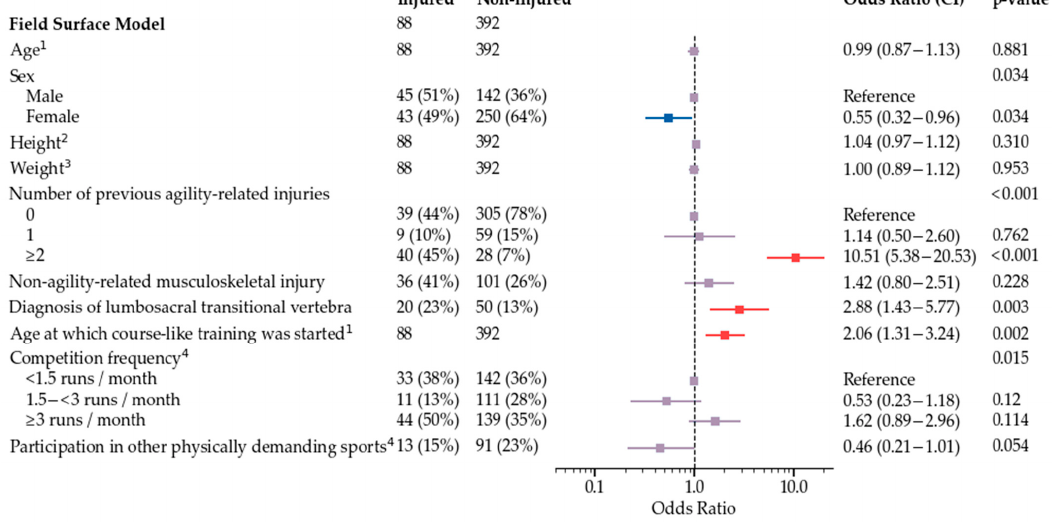
Figure 4. Field surface model for odds of agility-related injury during 2019. 1 For a one year increase, the odds increase by OR. 2 For a one centimeter increase, the odds increase by OR. 3 For a one kilogram increase, the odds increase by OR. 4 Routines during the three-month period preceding injury in injured dogs and during 2019 in non-injured dogs.